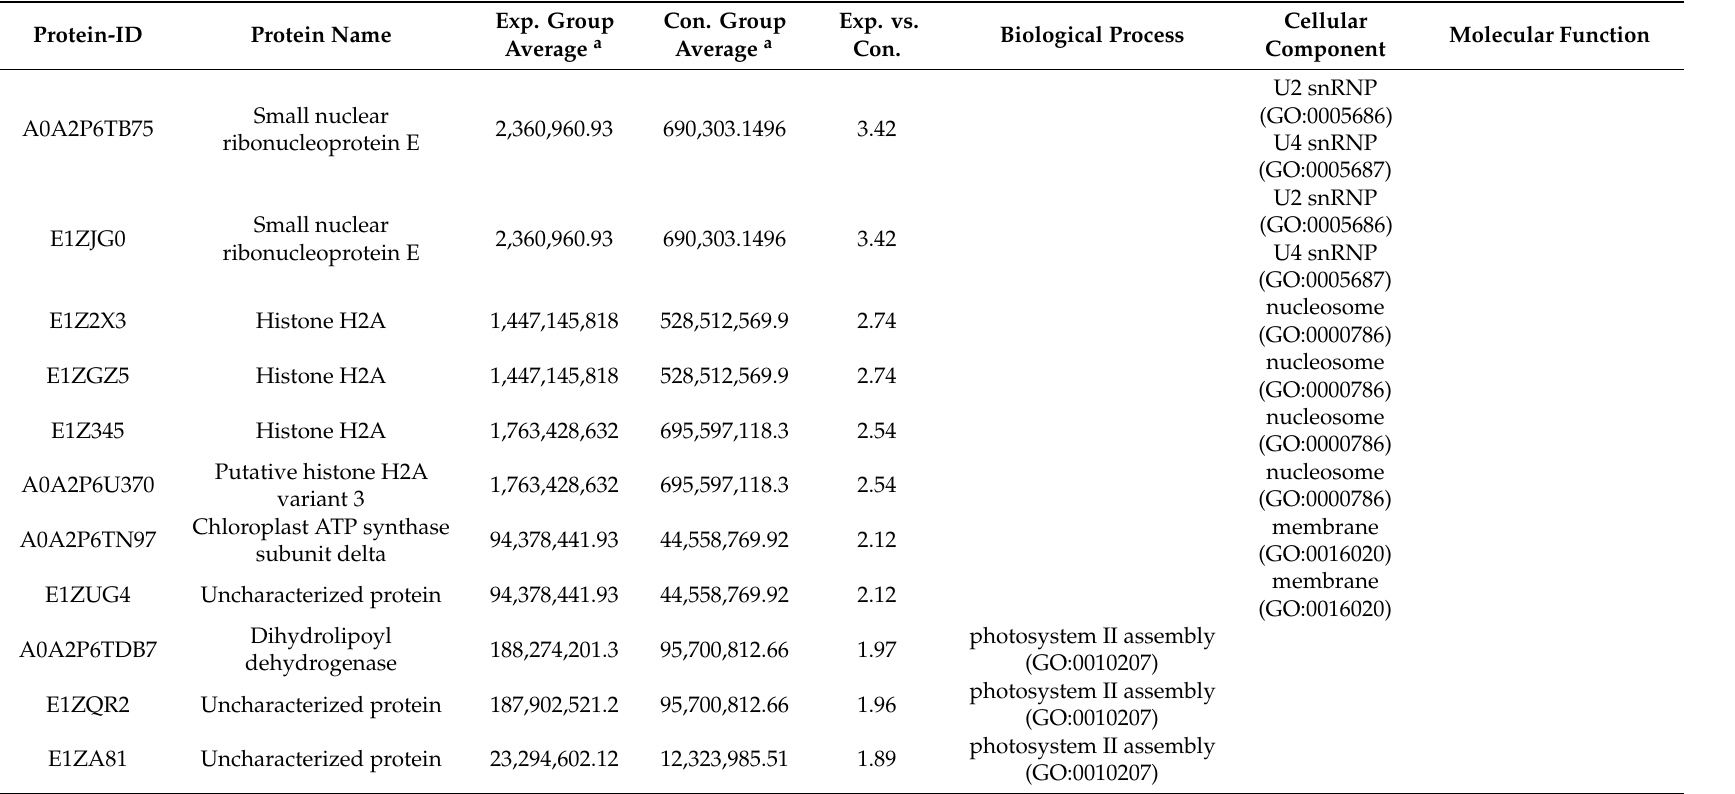
Table 3. Identification and GO annotation results of diethyl phthalates (DEPs) in C. vulgaris from Exp. and